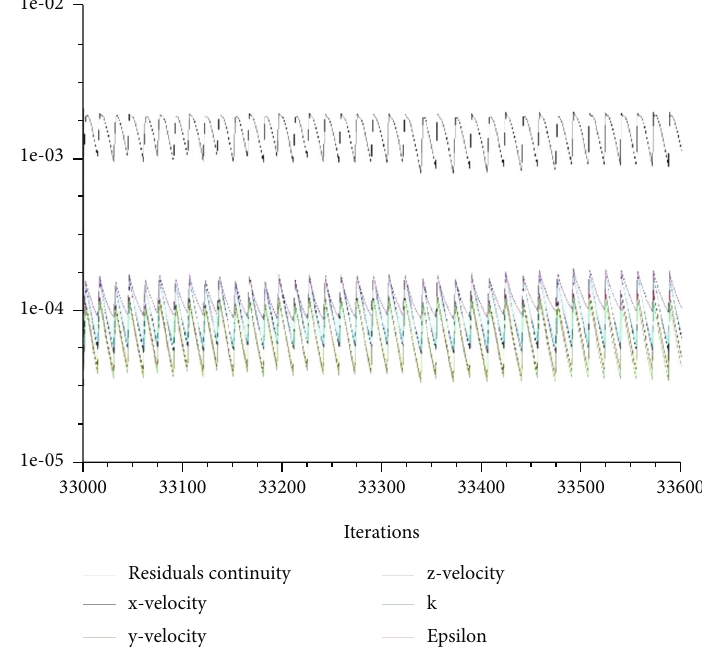
Figure 4: Residuals for 3D mesh with 2.2 million